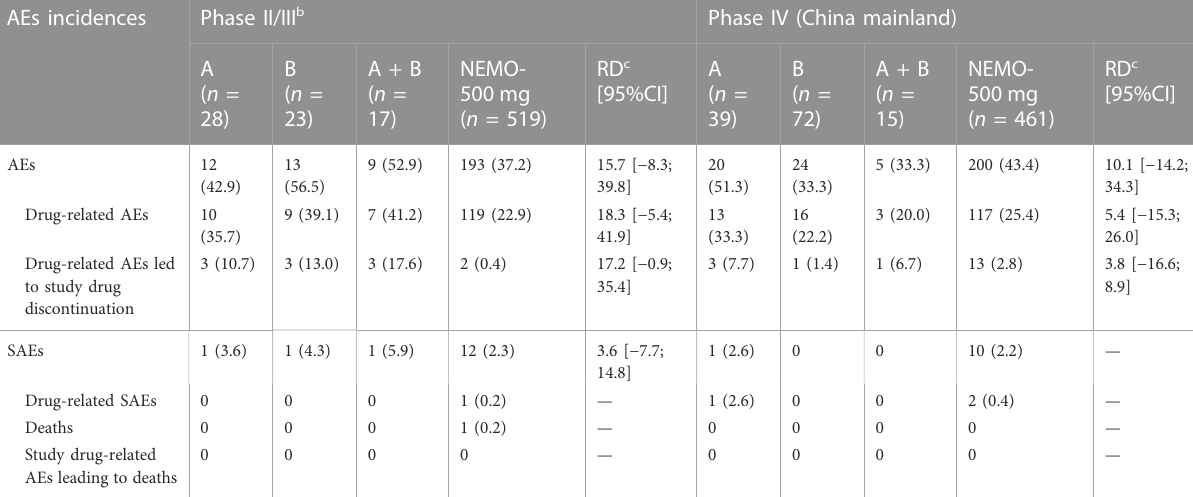
a Abnormal liver and kidney function included: A with liver and/or kidney function abnormal baseline values that were clinically; B with ongoing liver and/or renal abnormalities; A + B means both A and